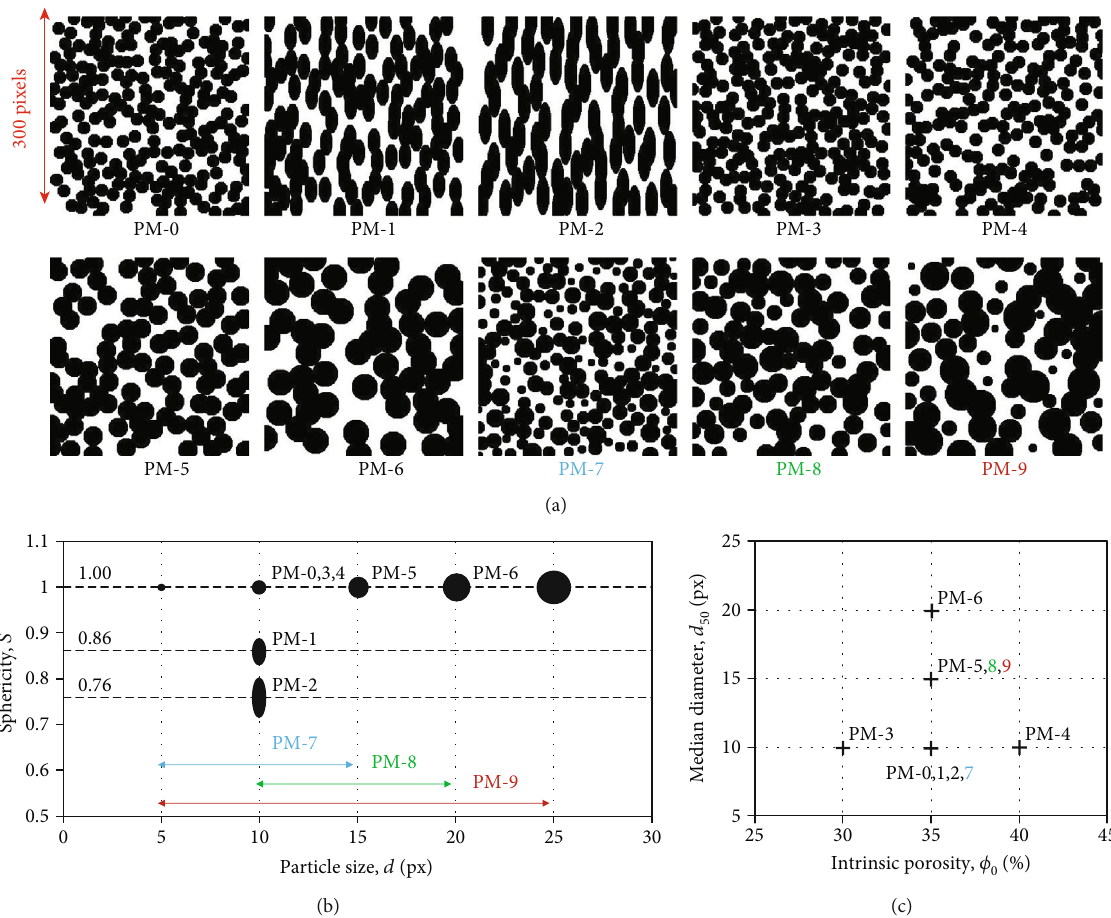
Figure 1: Arti fi cial porous media for further numerical simulations of hydrate nucleation and growth in this study. (a) Square images of arti fi cial porous media constructed by randomly placing and freely overlapping particles. The side length of square images is 300 px. Black color represents solid particles, and white color stands for fl uid-occupied pores. (b) Size d and sphericity S of solid particles used for porous media constructions. (c) Intrinsic porosity ϕ 0 of arti fi cial porous media and median diameter d 50 of solid value) for grain-coating hydrates (Figure 3(c)) and 1 : 0 ± 0 : 0 px (2.1% of the intrinsic value) for pore- fi lling hydrates (Figure 3(d)) when S h = 0 : 8 . The average value of intrinsic maximum hydraulic diameters Λ h0 of fl uid-occupied pores within ten porous media is 19 : 7 ± 9 : 1 px , and it decreases to 10 : 7 ± 3 : 7 px (54.3% of the intrinsic value) and 4 : 7 ± 0 : 6 px (23.9% of the intrinsic value) when S h = 0 : 8 for grain- coating (Figure 3(e)) and pore- fi lling (Figure 3(f)) hydrates, respectively. It is obvious that pore- fi lling hydrates reduce values of the maximum equivalent, incircle, and hydraulic diameters more e ffi ciently than grain-coating hydrates when S = 0 : 8 , and the maximum hydraulic diameter is the least h sensitive to hydrate saturation.